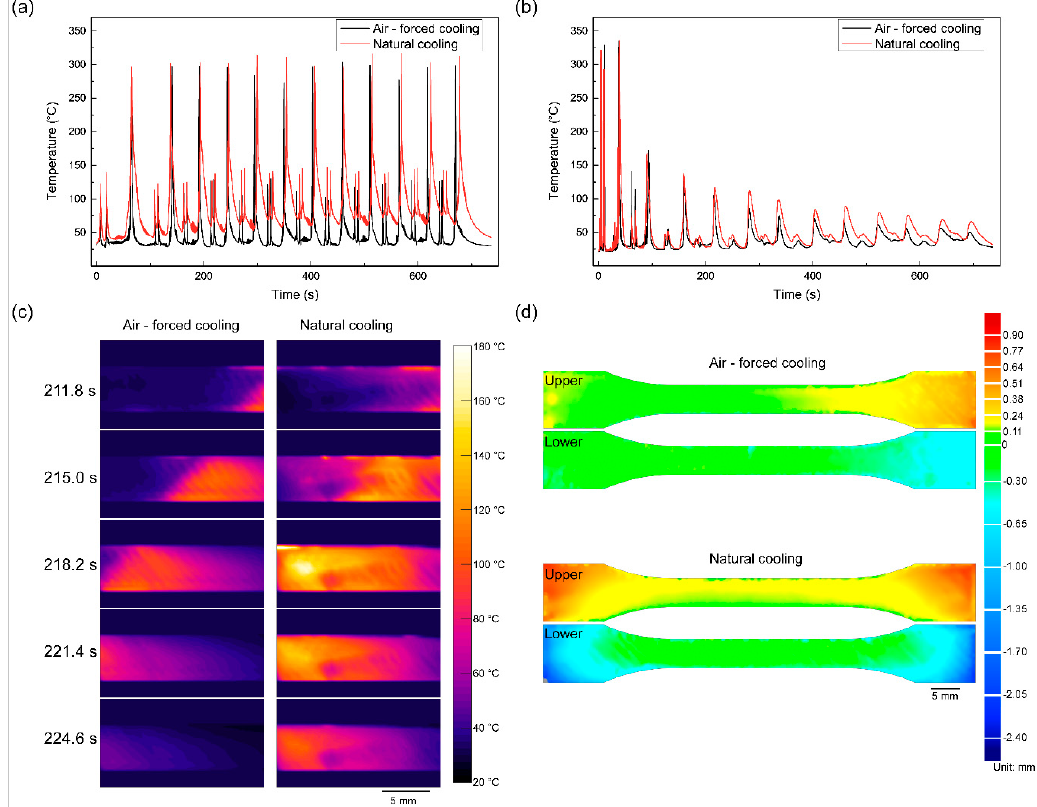
Figure 7. Evolution of the 3D-printed PPS temperature: ( a ) Temperature profile of the upper surface; ( b ) temperature profile of the lower surface; ( c ) infrared images showing the evolution of the lower surface temperature; ( d ) warpage of 3D-printed PPS samples.